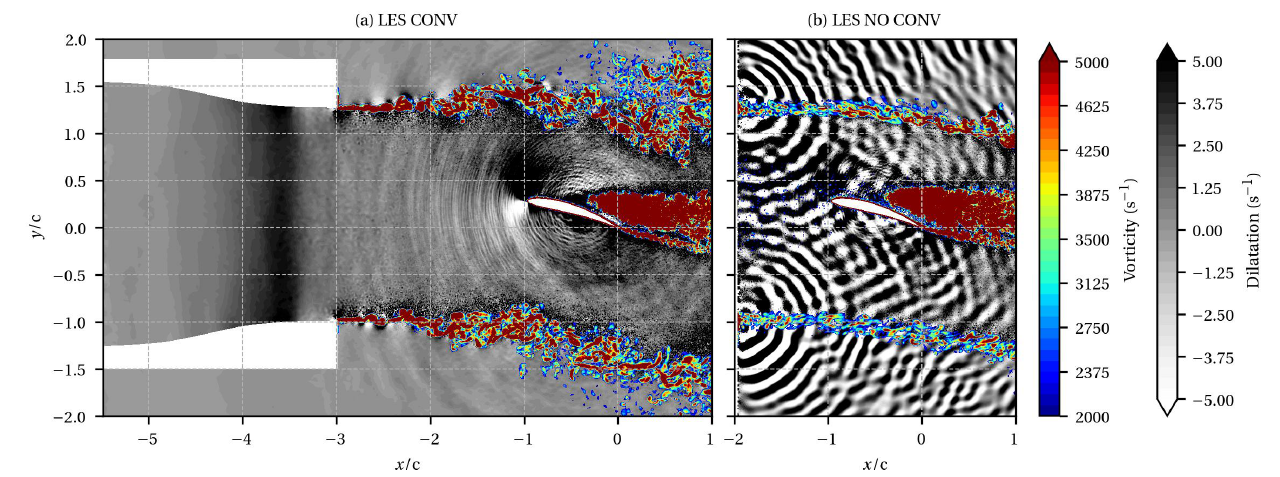
Figure 4. Instantaneous vorticity and dilatation fields with ( a ) and without ( b ) the convergent at z /c = 0.1.